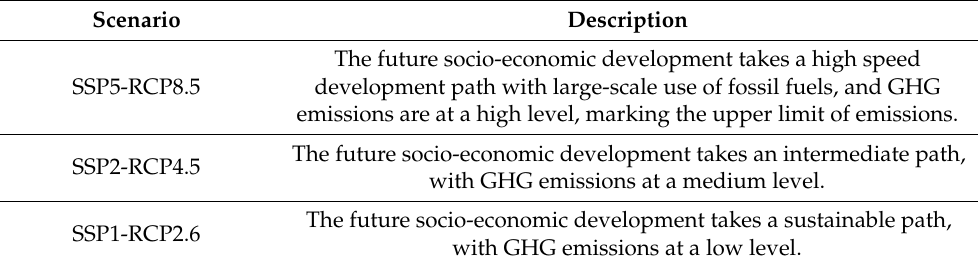
Table 2. Future development scenario selection and